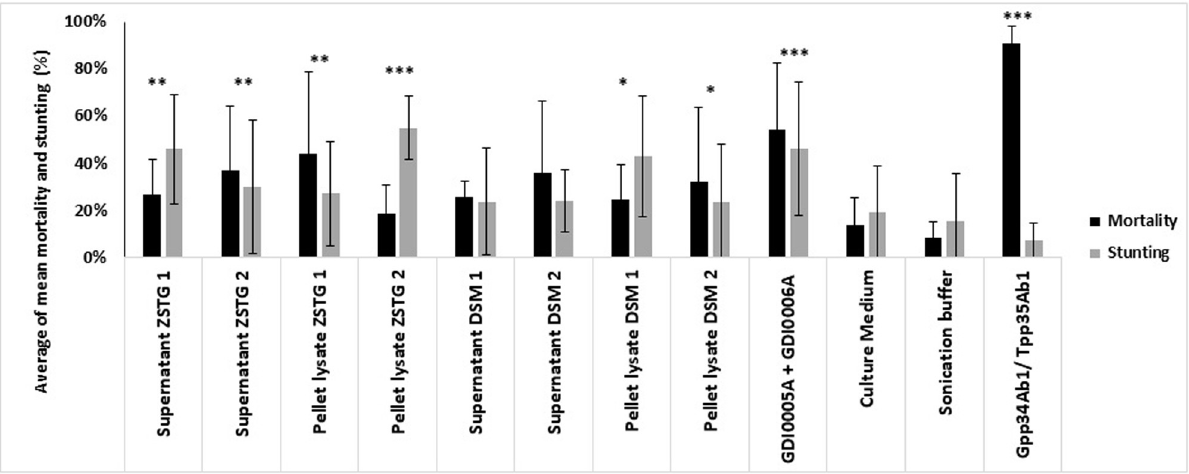
Fig 9. Assessment of the activity of 2 strains of Chryseobacterium arthrosphaerae (ZSTG2175 and DSM25208) on WCR neonates. Activity was evaluated 5 days after treatment and infestation using a diet overlay bioassay by assessing the percentage of mortality (black boxes) and the percentage of stunting (grey boxes). Each WCR larvae was exposed to ~200 μ L of WCR artificial diet overlaid with 20 μ L of supernatant or pellet lysates of both strains (ZSTG 1 and DSM 1: first replicate of ZSTG2175 and DSM25208; ZSTG 2 and DSM 2: second replicate of ZSTG2175 and DSM25208). Negative controls were the culture medium and sonication buffer. The positive control were lysates from E . coli transfected with a plasmid expressing the commercial Gpp34Ab1/Tpp35Ab1 binary proteins. For each experiment, a total of 48 WCR neonate larvae were analyzed. A Fisher exact test was used to compare treatment results to the culture medium at significance levels of P < 0.05 � , < 0.005 �� , < 0.001. The error bars show the standard error of the mean